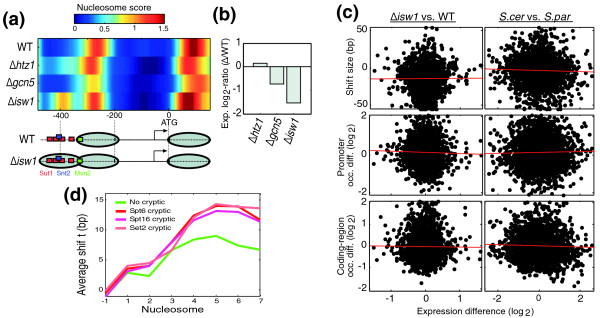
Isw1 effects on gene expression and cryptic initiation. (a) Nucleosome scores for TMA10 show stabilization of the -2 nucleosome in Δisw1, which covers multiple binding sites [57]. (b) Log2 expression ratios (mutant divided by wild type (WT)) for TMA10 in the three deletion strains. (c) Expression differences are not correlated with Isw1-dependent changes in nucleosome positioning for both comparison of wild-type with Δisw1 cells (left) and comparison of the two species (right). Left: scatterplots of log2 expression changes in Δisw1 versus changes in nucleosome positioning in Δisw1. Right: scatterplots of log2 expression ratios of the two species versus difference in the effects of ISW1 deletion on nucleosomes in the two species. Top: shift size at the +5 nucleosome; in the right panel, minus and plus reflect upstream and downstream shifts, respectively, and in the left panel they reflect larger Isw1 shifts in S. cerevisiae and S. paradoxus, respectively. Middle: differences in promoter occupancy. In the right panel, log2-ratio of the number of reads that map to within 250 bp upstream of the TSS in Δisw1 versus wild type. In the left panel, differences in that log2-ratio between the two species. Bottom: differences in coding-region occupancy. Same as in the middle panel but for reads that map to the first 500 bp of each coding region. In all cases, red lines represent the linear least square fit, and no significant correlation was observed (P > 0.05). (d) Average sizes of Isw1-dependent upstream shifts at nucleosomes +1 through +7 for genes with detected cryptic initiation in three mutant strains (for Spt6, Spt16 and Set2) and for genes without cryptic initiation in any of the three mutants. The three datasets of cryptic initiation include 960, 1,130 and 429 genes, respectively, and are all strongly associated with long genes (median length of 2,063, 2,090, and 2,453, compared to 857 for genes without cryptic initiation). Long genes are also enriched with Isw1-dependent shifts (Figure 4d; Figure S6 in Additional file 1).